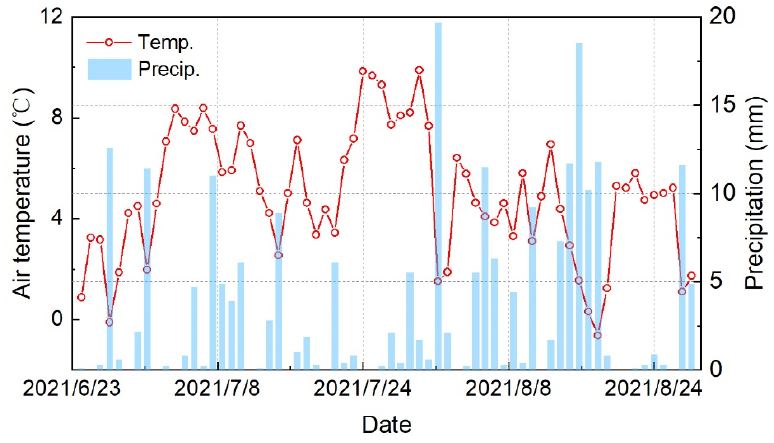
Figure 10. Air temperature and precipitation measured at the automatic weather station from 24 June to 28 August 2021.